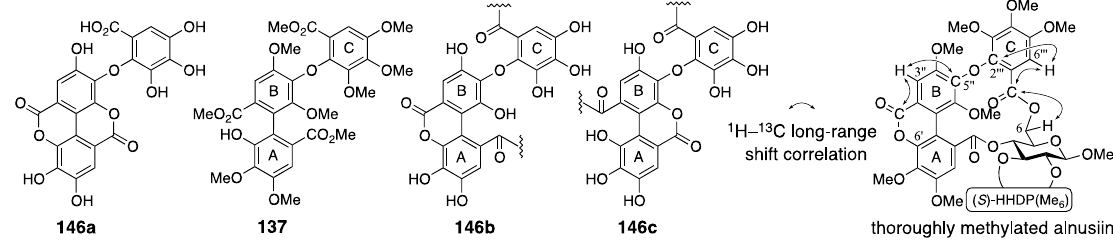
Figure 49. The compounds used for considering the latest structure of alnusiin 134 .